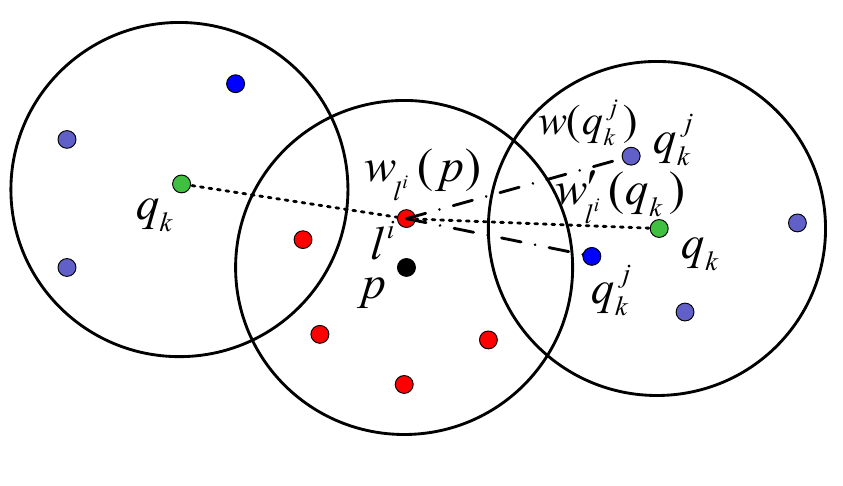
Figure 2. The weight of